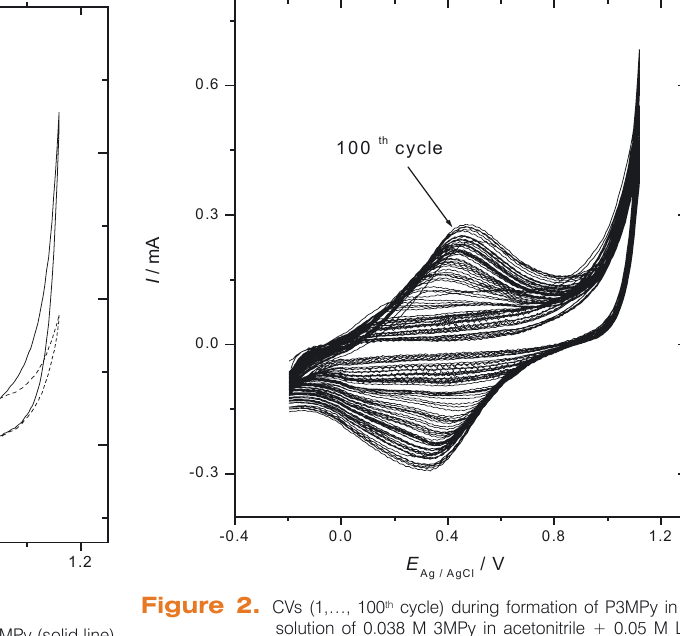
Figure 2. CVs (1,…, 100 th cycle) during formation of P3MPy in a solution of 0.038 M 3MPy in acetonitrile + 0.05 M Li- Figure 1. CVs of a gold electrode in a solution of 3MPy (solid line) ClO4, -0.20 < E < 1.10 V, gold electrode, d E /d t = and the (3MPy- β -DMCD) complex (dashed line) in ac- Ag/AgCl 50 mV·s -1 etonitrile + 0.05 M LiClO , - 0.20 < E < 1.10 V, d E / 4 Ag/AgCl d t = 50 mV·s -1 .